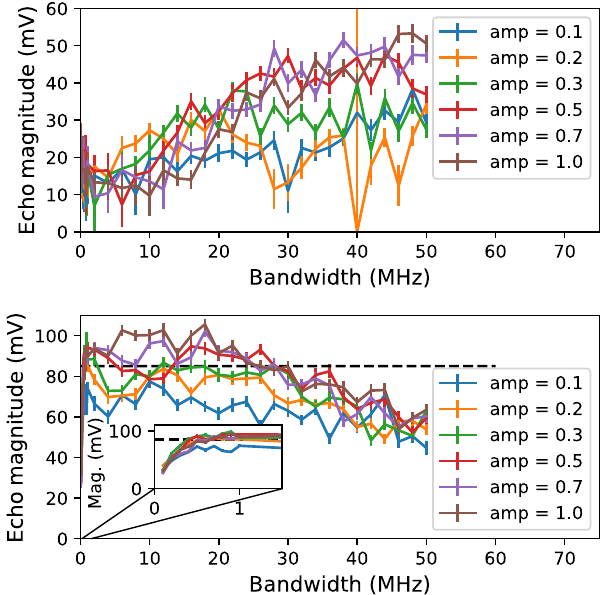
FIG. 13. Top (bottom): amplitude of the first (second), nomi- nally silenced (unsilenced), echo as a function of the pulse bandwidth for 200 μ s WURST pulses. Inset to the bottom panel is the unsilenced data for low bandwidths, showing that there is a minimum bandwidth, similar to the cavity width, required to maximize the echo amplitude by refocusing all the spins in the cavity. The adiabaticity limit is determined by thresholding the unsilenced echo intensity relative to 85 mV shown as a black dashed line. The variation in echo amplitude was used to derive the uncertainties in the data points shown in Fig.